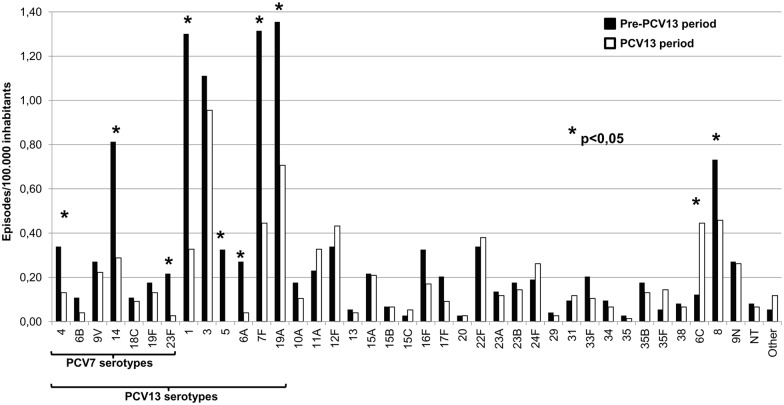
Incidence of invasive pneumococcal disease by serotype and by period.Asterisks indicate serotypes with statistically significant changes (p≤0.05). All p values were ≤ 0.001 with the exception of serotypes 4 (0.012) and 8 (0.049).